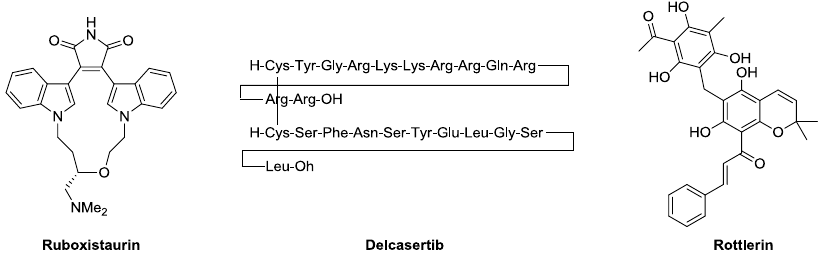
Figure 3. Ruboxistaurin and delcasertib have entered in clinical trials. Rottlerin, a PKCδ (nPKC) selective inhibitor.